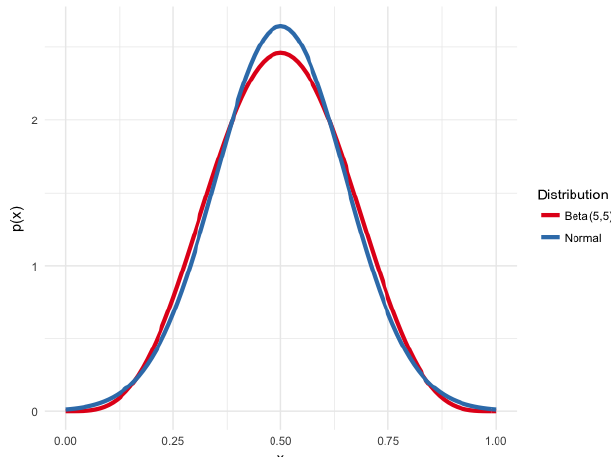
Figure 8. Comparison of the beta(5,5) distribution and a normal dis- tribution with equal variance. The beta distribution is zero outside of the depicted range, while the normal distribution asymptotically approaches zero. Although the difference between these two distri- butions is small, the Shapiro–Wilk test can easily distinguish